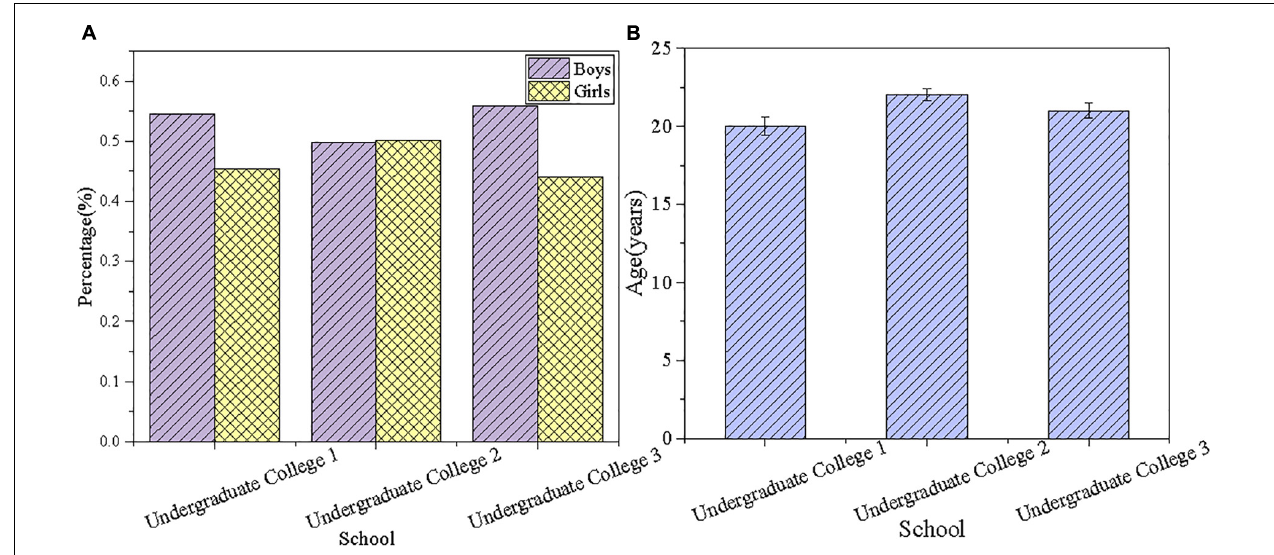
FIGURE 2 | Descriptive analyses of respondents ( A : gender ratio; B : age distribution).